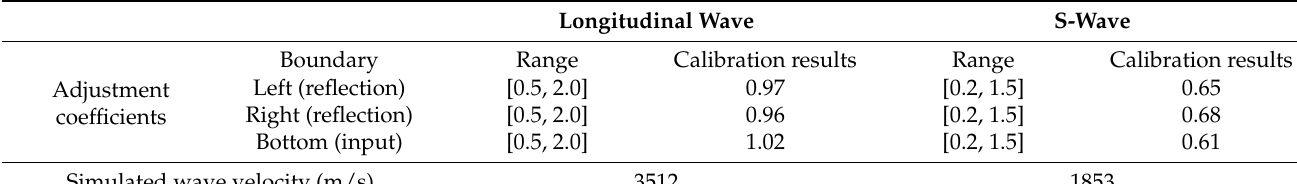
Table 2. Values of adjustment coefficients of viscous boundaries in the rockfill slope.